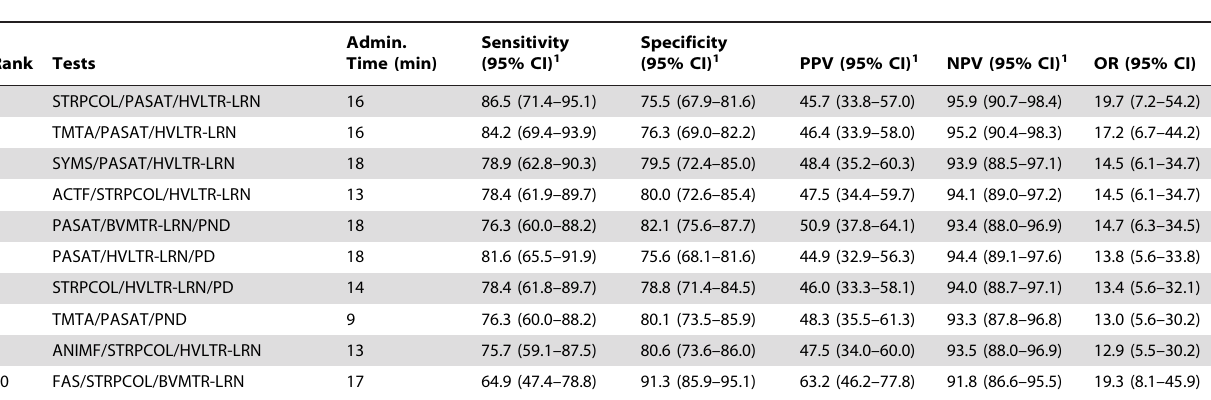
Table 3. Top 10 3-test combinations, ranked according to sum of sensitivity and specificity compared to a 120 minute global neuropsychological